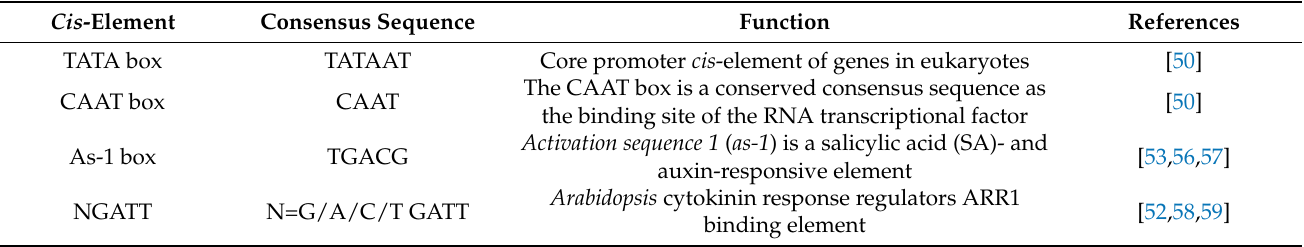
Table 3. Predicted cis -acting elements of the BoCKX genes and its